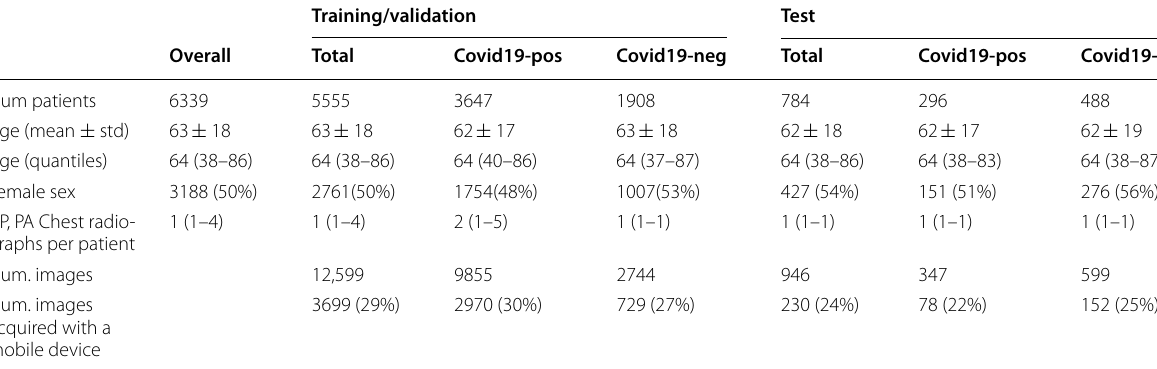
Age variables are presented as the mean and standard deviation and also using 10% and 90% quantiles. For the number of female cases, absolute and percentage values are shown. Quantiles are also used for the number of chest radiographs per patient